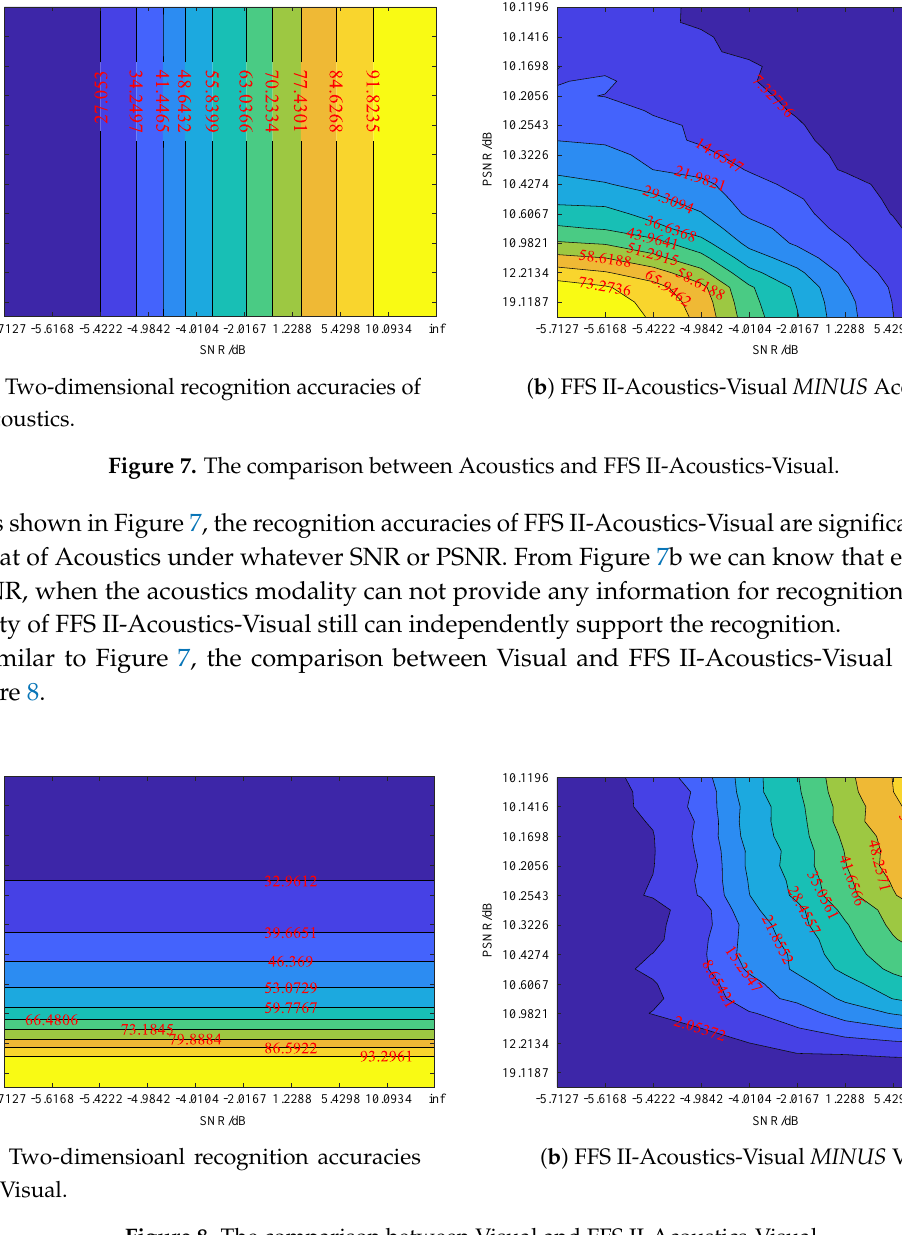
Figure 8. The comparison between Visual and FFS